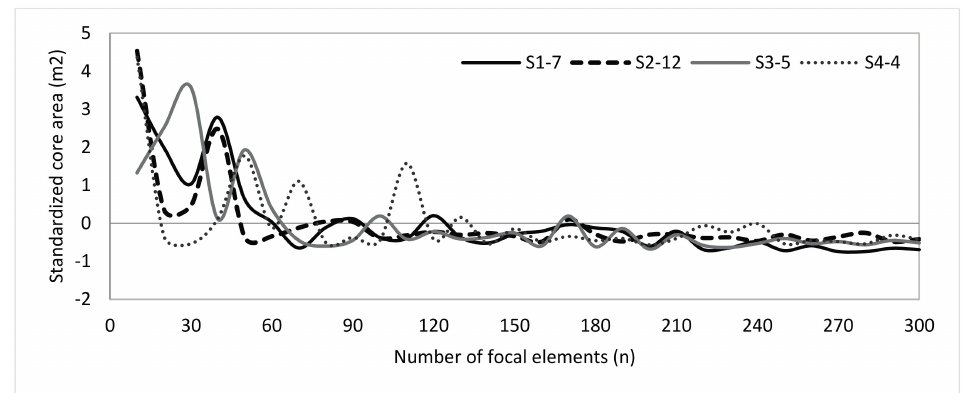
Figure 8. The curve of differences between two successive standardized core sets d i . When d i is in the range − 1 to +1, we determined this n value for performing random sets (see notations in Figure 7 for the name of subsets).